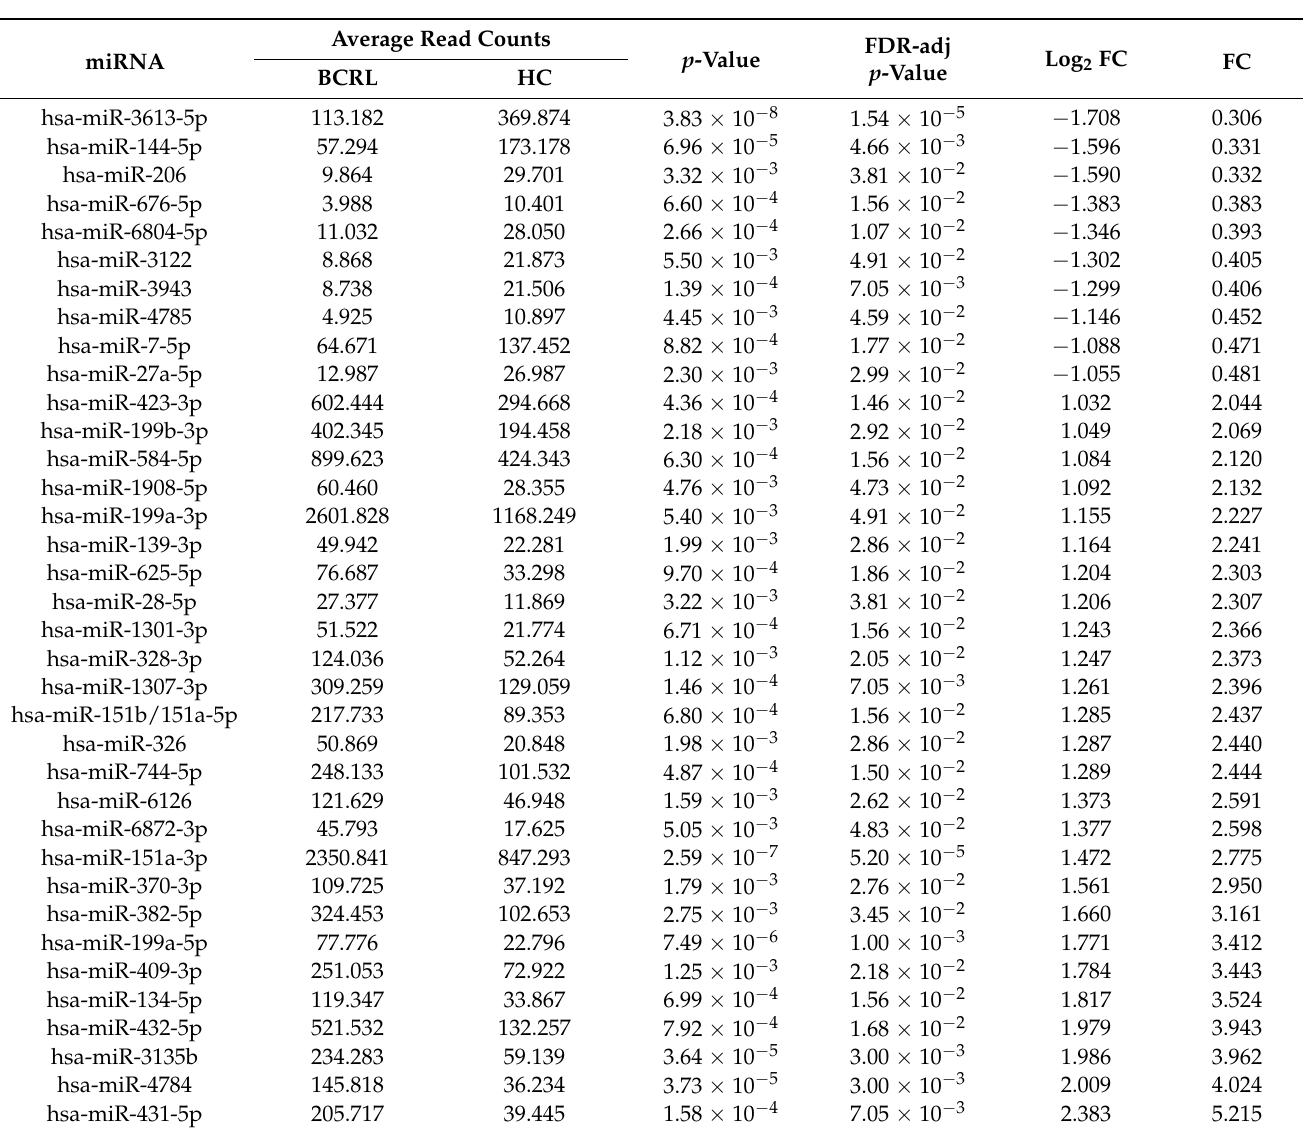
Table 2. Differentially expressed miRNAs in BCRL cases compared to HCs revealed by small RNA-sequencing. The FDR-adjusted p -value (Benjamini–Hochberg), p < 0.05 was considered statistically